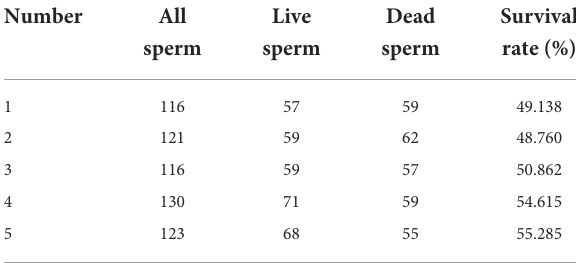
TABLE 3 Sperm activity test